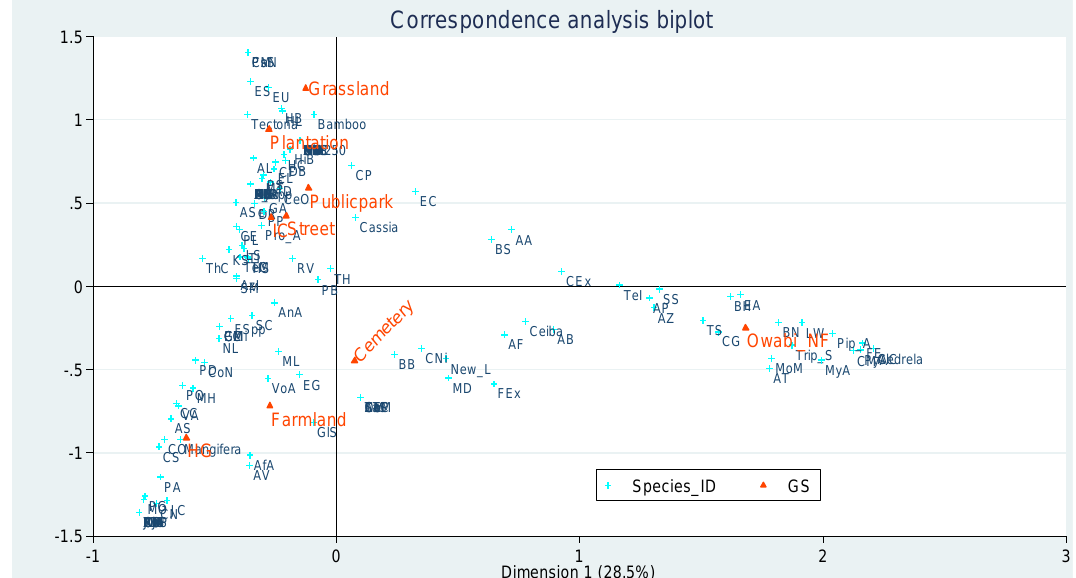
Figure 3. Output of correspondence analysis for the tree species in different green spaces (GS) in Kumasi metropolis. Dimension 1 represents green spaces while dimension 2 represents plant species.